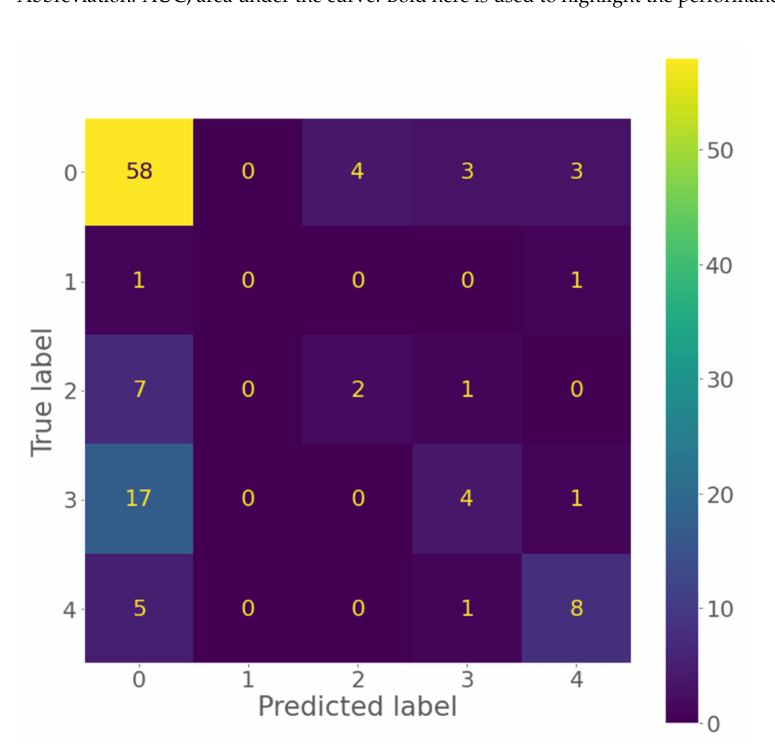
Figure 3. Confusion matrix for distribution classification in one fold of five-fold cross